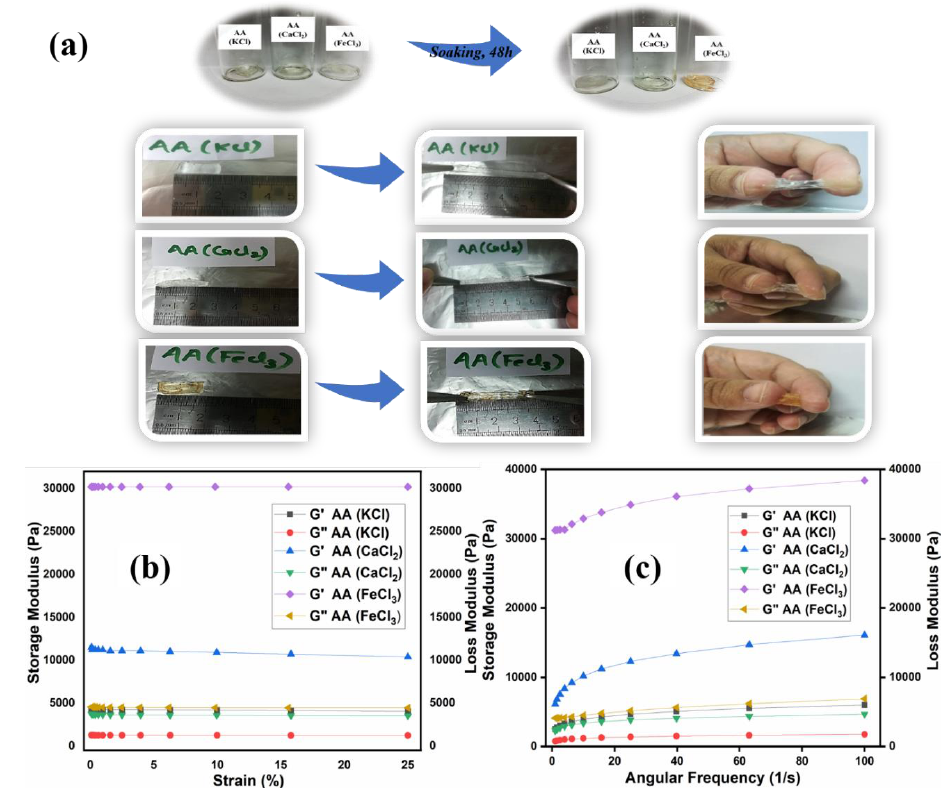
Figure 12. ( a ) Mechanical strength of the hydrogels, ( b ) strain amplitude test, and ( c ) frequency sweep study [140] .